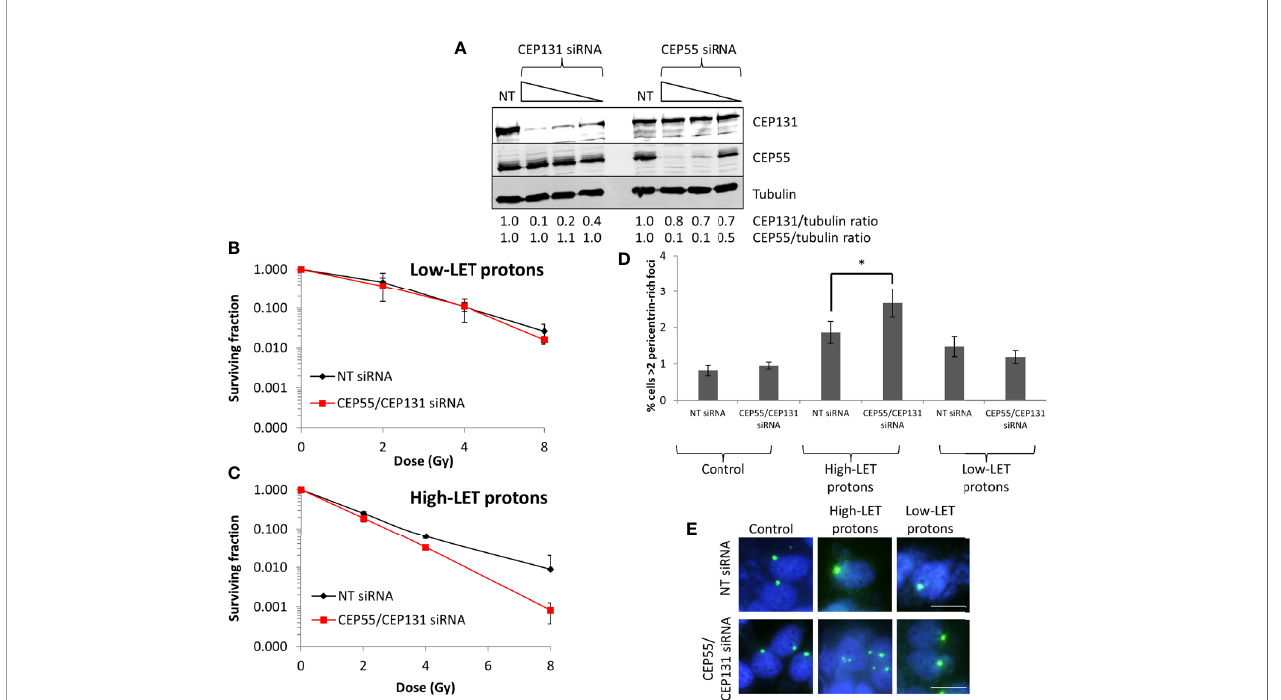
FIGURE 7 | CEP55 and CEP131 depletion induces pericentrin-rich foci ampli fi cation and reduces cell survival in response to relatively high-LET protons. (A) HeLa cells were treated with CEP55 or CEP131 siRNA (0.01, 0.1 and 1 nM) or a non-targeting (NT) control siRNA for 48 h, and whole cell extracts were analyzed by immunoblotting using the indicated antibodies. Protein levels of CEP131 and CEP55 relative to tubulin and normalized to the NT siRNA control-treated cells which was set to 1.0 are shown. (B – E) HeLa cells were treated with CEP55 and CEP131 siRNA (0.01 nM) or a non-targeting (NT) control siRNA for 48 h. Cells were irradiated with increasing doses of (B) low-LET protons or (C) relatively high-LET protons. Clonogenic survival of cells was analyzed from 2 independent experiments, and shown is the mean surviving fraction ± S.E. (D, E) Alternatively, analysis of pericentrin was performed by immuno fl uorescence 48 h post-irradiation (with 4 Gy). (D) Shown is the mean percentage of cells with >2 pericentrin-rich foci/nucleus ± S.D. *p < 0.05 as analyzed by a two-sample t -test. (E) Representative images of pericentrin staining (green stain) and nuclei (blue stain;